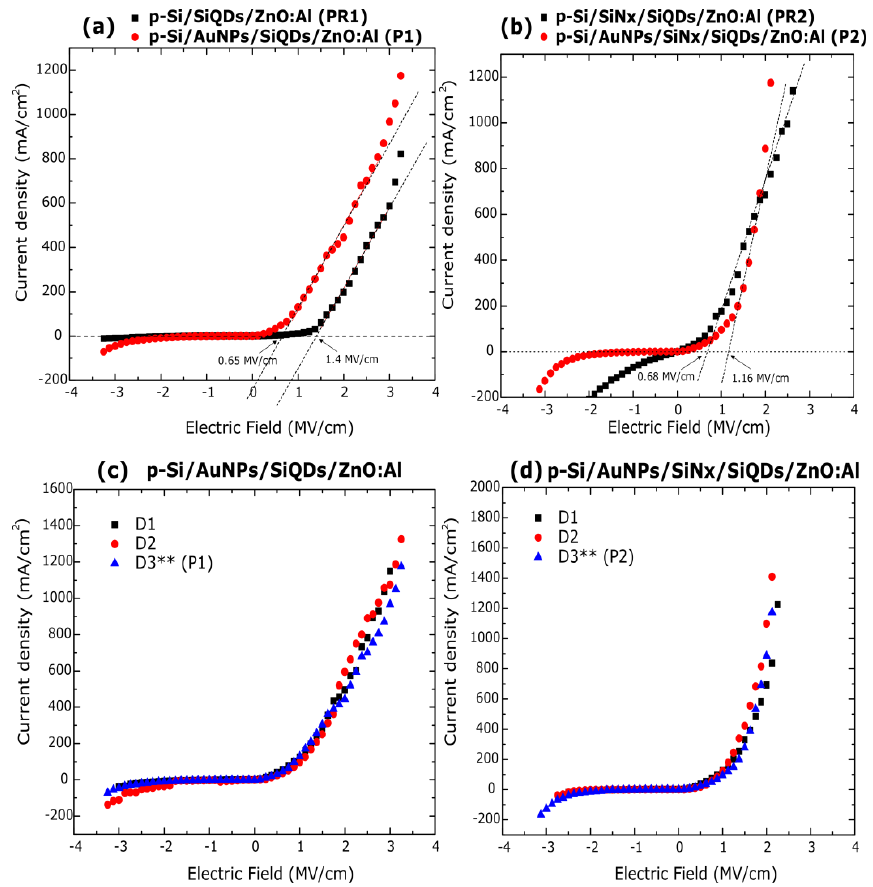
Figure 8. Current density-electric field characteristics of the ( a ) P1 and PR1 and ( b ) P2 and PR2 samples. Current density-electric field plots of three different devices of the P1 ( c ) and P2 ( d ) structures; a double asterisk denotes the P1 and P2 samples in each graph corresponding to the device D3.